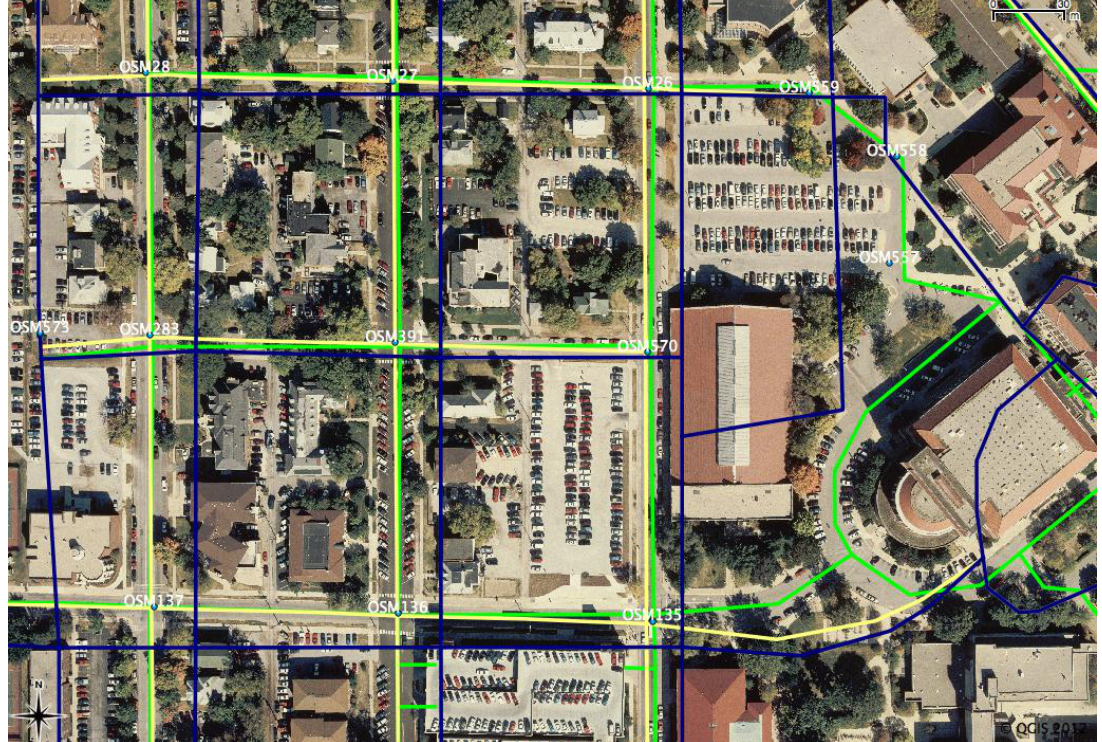
Figure 7. OSM (green), USGS National Map (TNM) (yellow) and United States Census Bureau’s Topologically Integrated Geographic Encoding Referencing (TIGER) 2007 (blue) roads.